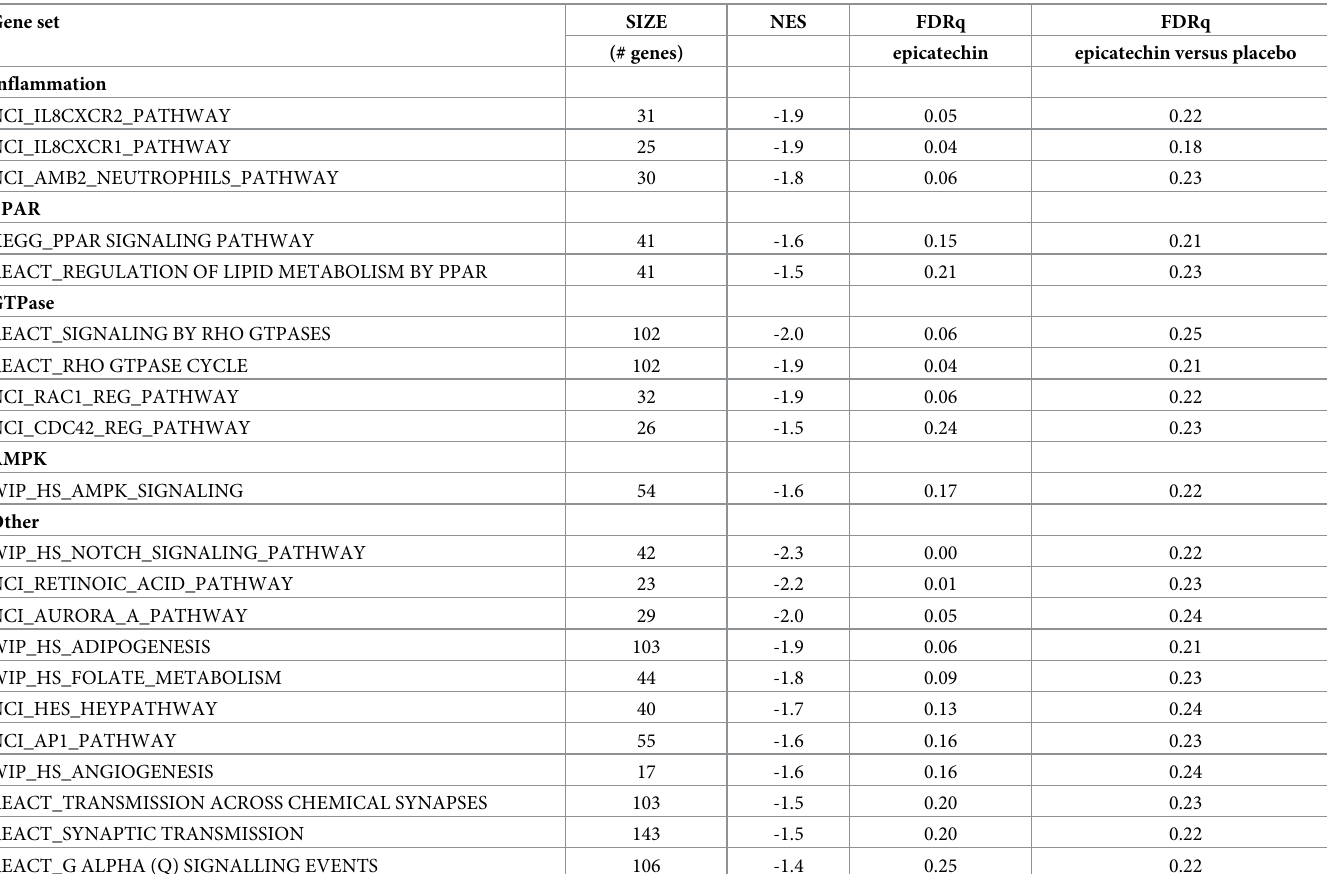
Table 4. Gene sets significantly downregulated within the epicatechin intervention (epicatechin) and between intervention arms (epicatechin versus placebo). Gene